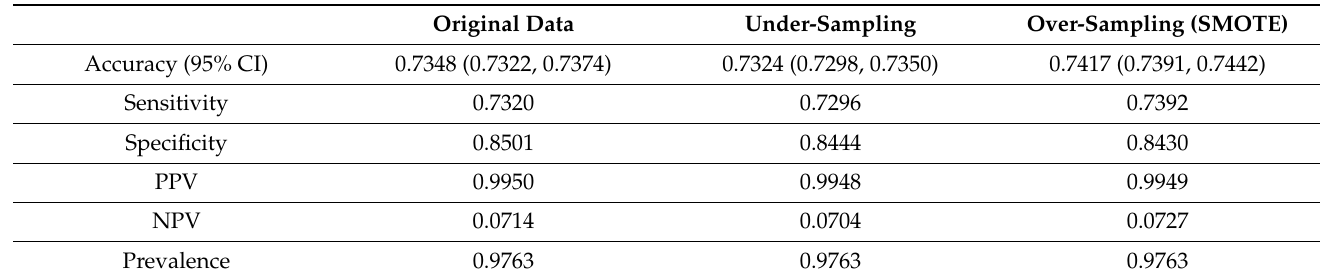
Table 7. Comparison of XGB performance according to sampling method.